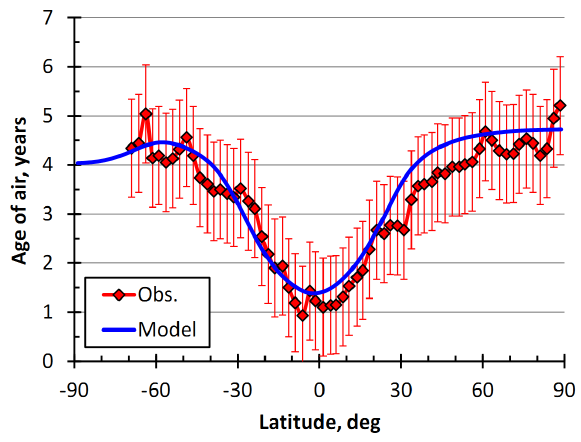
Fig. 1. Mean age of air at 20 km altitude from NIES TM simulations (blue line), compared with the mean age of air derived from in situ ER-2 aircraft observations of CO 2 (Andrews et al., 2001) and SF 6 (Ray et al., 1999) (red line). Error bars for the observations are 2σ (Monge-Sanz et al., 2007).